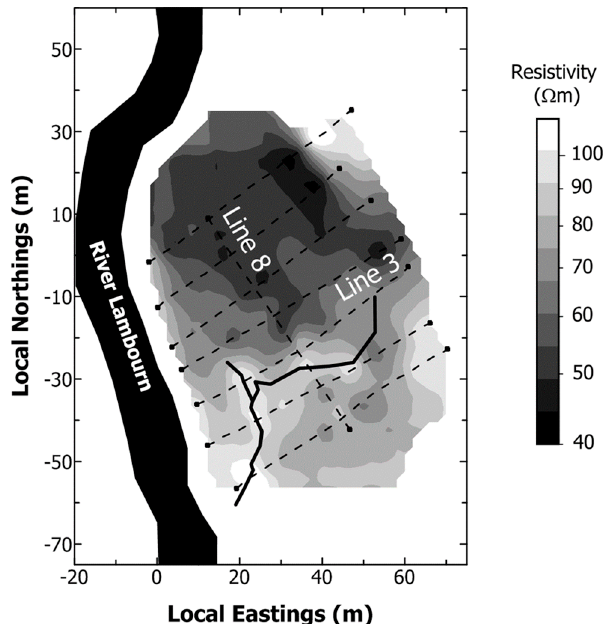
Figure 3. Variation across the site (between 0.65 m and 1.0 m below ground level) determined from resistivity images computed from electrical resistivity tomography (ERT) surveys along the eight transects (locations shown as broken lines).